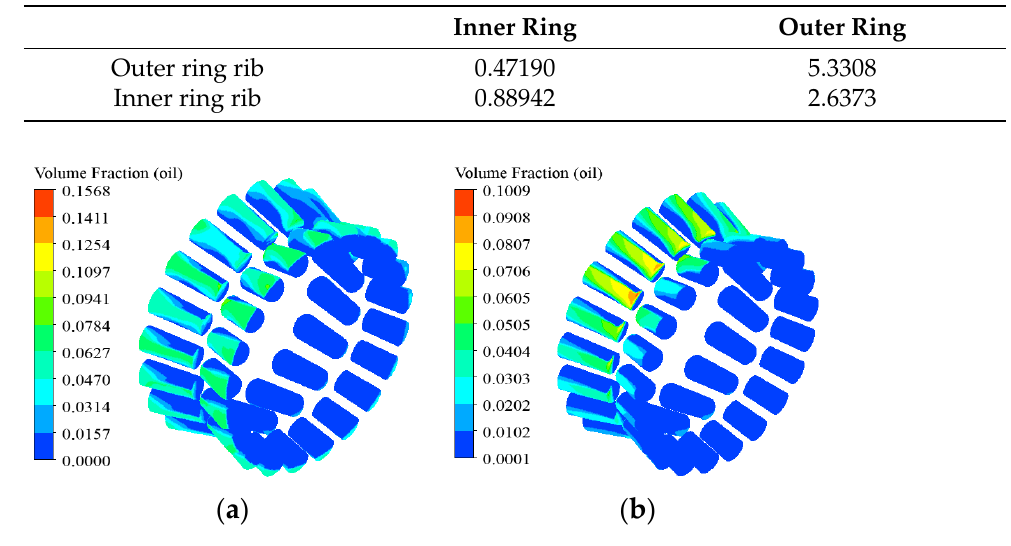
Figure 10. Oil distributions on the inner/outer ring wall of the bearings. ( a ) Outer ring rib structure; ( b ) Inner ring rib structure. Table 5. Average volume fraction of lubricating oil on the inner/outer ring wall (%).